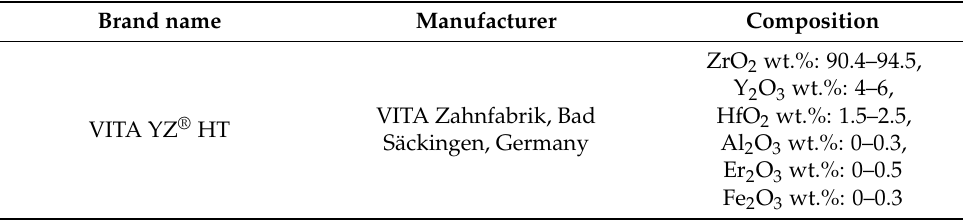
Table 1. Brand name, manufacturer and chemical composition of the material tested.